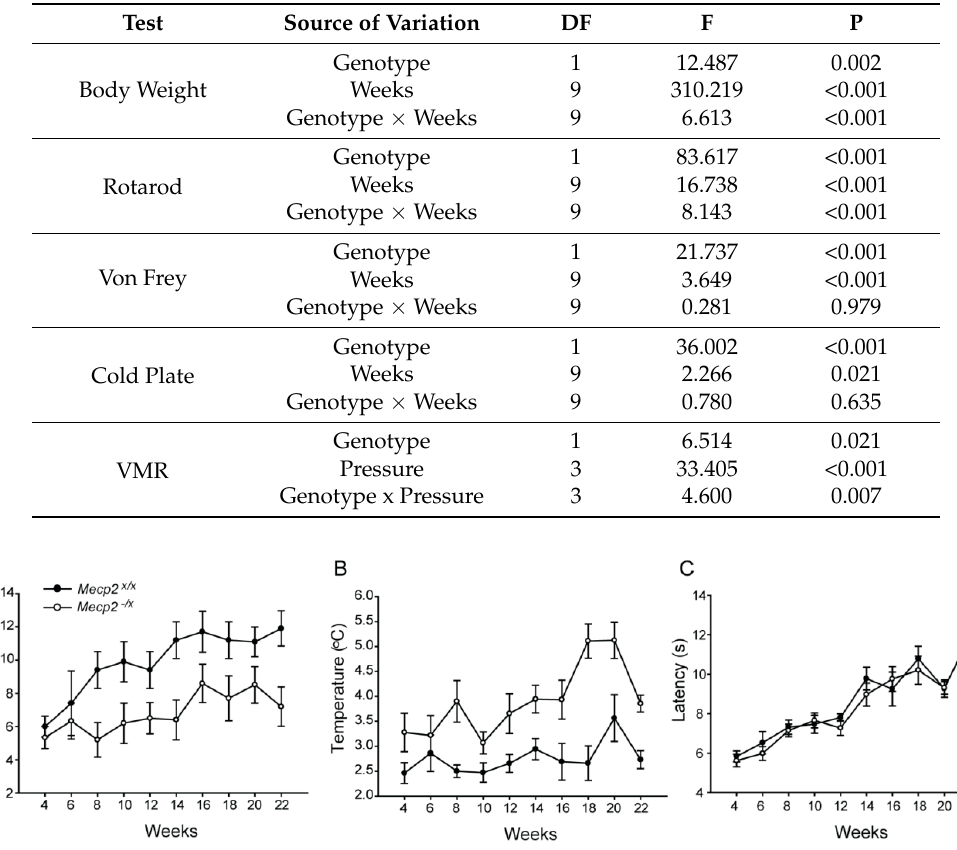
Figure 2. Somatic sensitivity in the RTT rat model. ( A ) Biweekly measurements using von Frey monofilaments reveals mechanical hypersensitivity in Mecp2 − /x rats at all ages starting from eight weeks (Holm-Sidak post hoc comparisons, p < 0.001 at 8–22 weeks); ( B ). Biweekly measurements of noxious cold sensitivity using the cold plate reveals hypersensitivity in Mecp2 − /x rats at all ages starting from 8 weeks (two-way repeated measure ANOVA, Holm-Sidak post hoc comparisons, p < 0.001); ( C ) Noxious heat sensitivity tested using the Hargreaves Paw Thermal Analgesiometer. No difference between the two groups registered during the entire testing period. ( n : WT = 10, Mecp2 − /x = 14). Further details of statistical parameters for ( A , B ) in Table 1. All graphs represent Mean ± SEM.